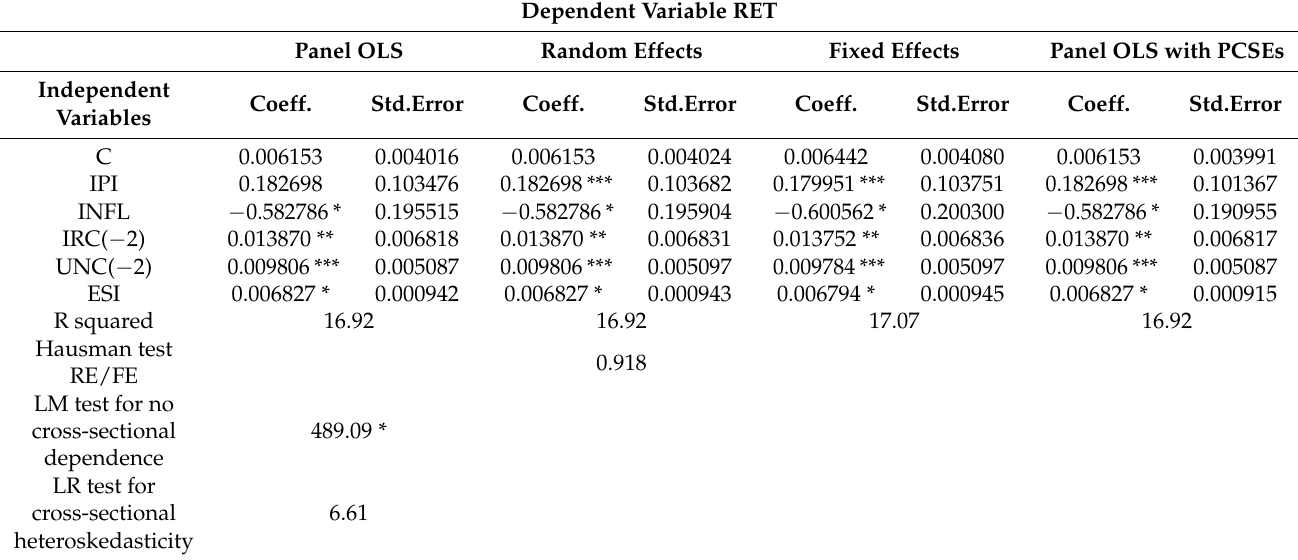
Table 4. Results for Core